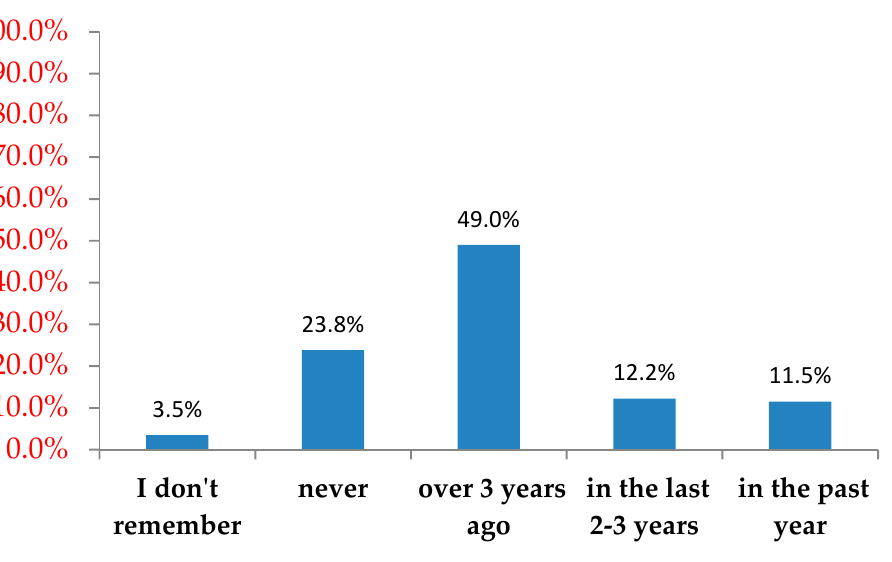
Figure 1. Previous CPR experience.